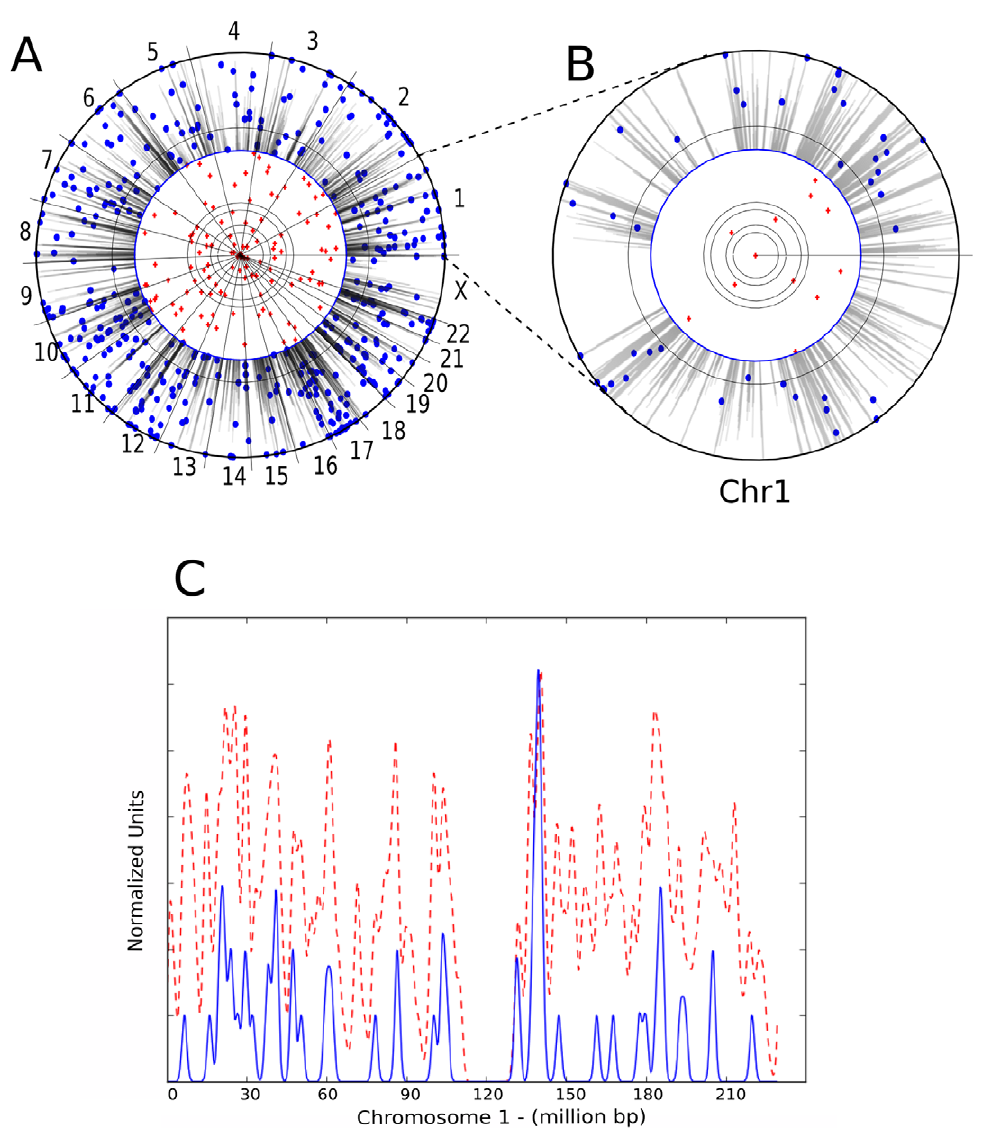
Figure 9. Visualization of association between retroviral integration sites and the chromosomal supermarker. ( A ) Chromosome projection mandala showing MLV proviruses from HeLa cells plotted as in Figure 1 and 2 with supermarker density (gray shading) from the 2 kB circle to the contour of the circle. ( B ) Chromosome projection mandala for chromosome 1 in isolation. ( C ) Plot showing density of supermarker (red dashed line) vs MLV proviruses (solid blue line) in HeLa cells, calculated over a 10 kB sliding window on chromosome 1. Pearson correlation is 0.81 for chromosome 1 and 0.75 for the whole genome.